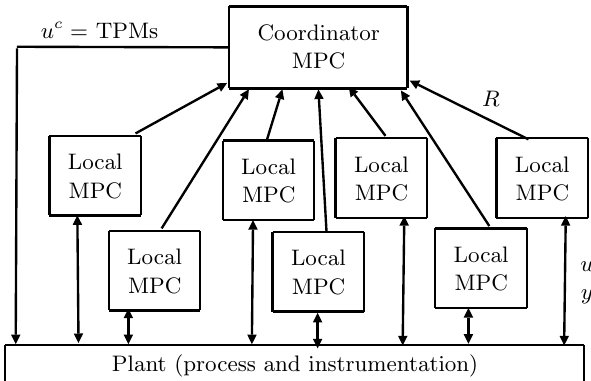
Figure 2: Proposed control structure where the coor- dinator MPC receives information from the local MPC about the remaining capacity ( R ) in the